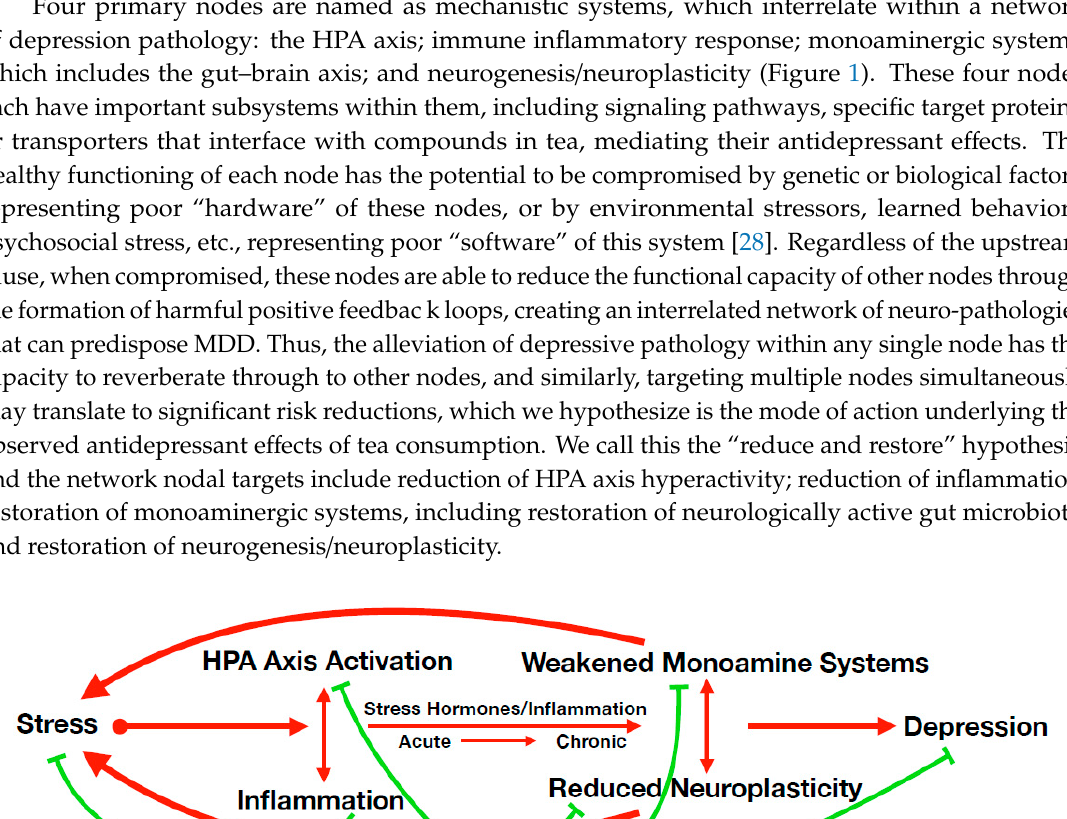
exacerbating e ff ect. HPA,